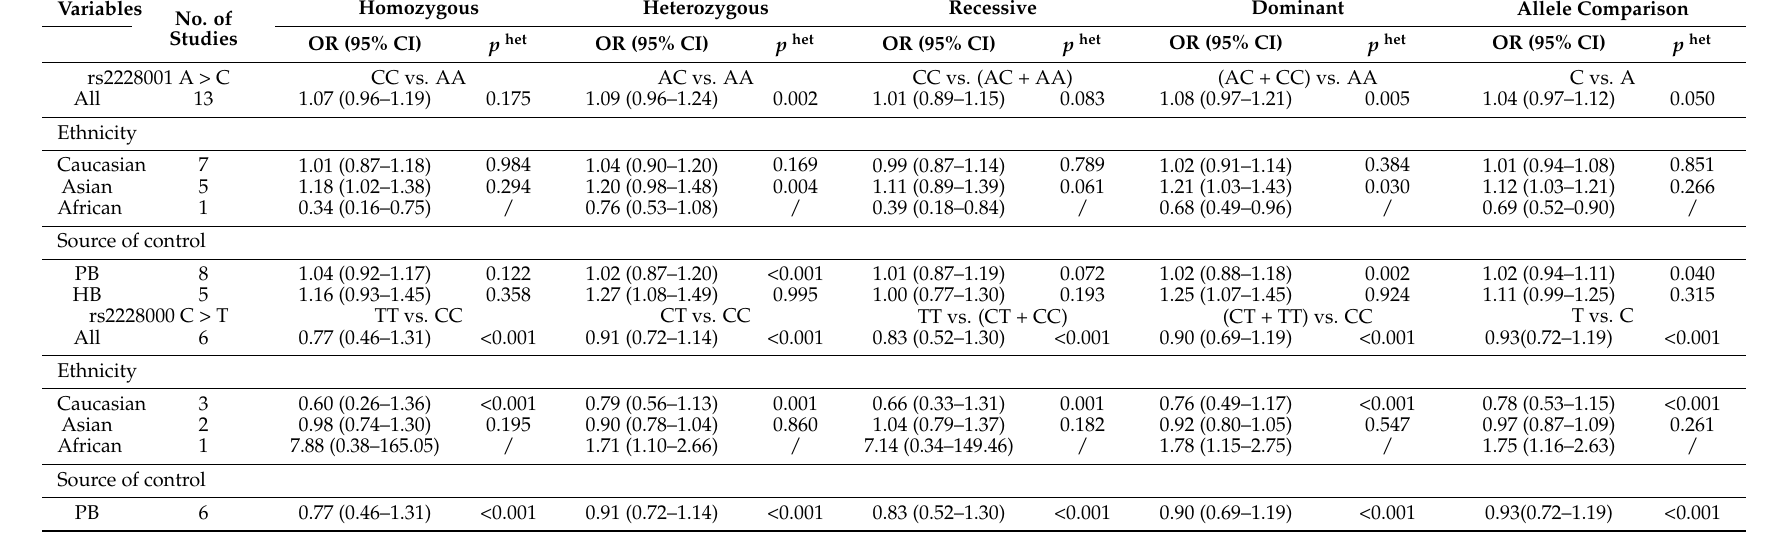
Table 5. Meta-analysis of the association between XPC rs2228001 A>C and rs2228001 C>T polymorphisms and colorectal cancer